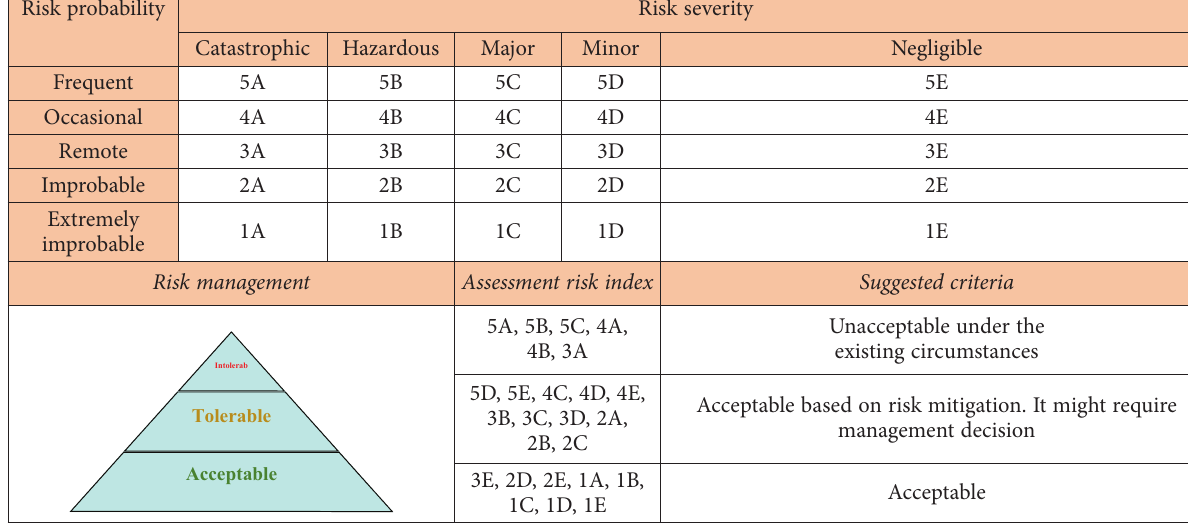
Figure 2. 2D risk matrix including three risk